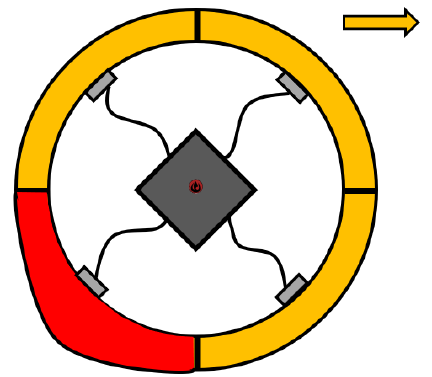
Figure 7. Principle sketch of deforming the outer